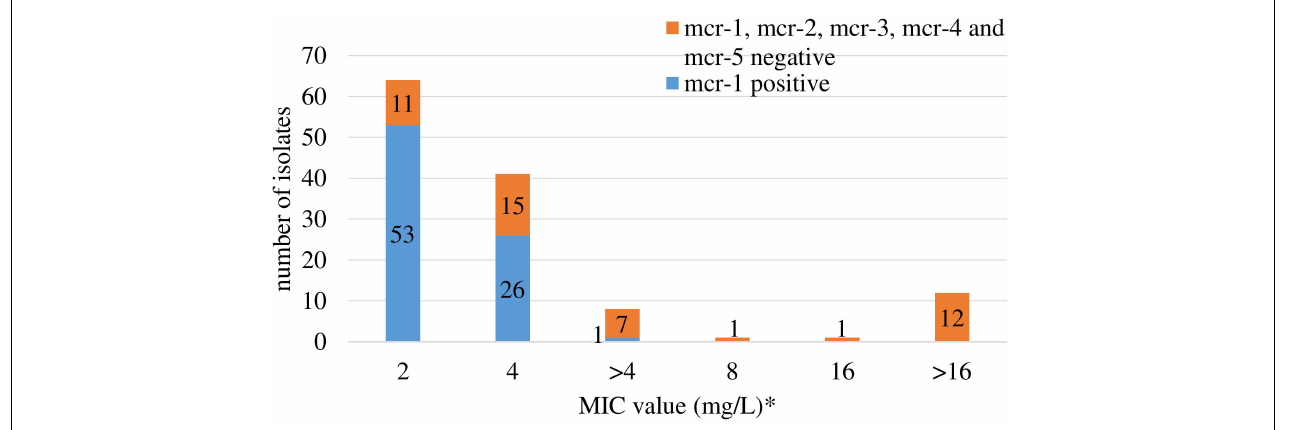
FIGURE 1 | Colistin MIC distribution and occurrence of the mcr-1 and mcr-2 gene among 128 Escherichia coli selected based on colistin MIC > 2 mg/L (2011–2013) and ≥ 2 mg/L (2014–2016). ∗ only isolates with MIC colistin ≥ 2 mg/L were tested for mcr-1 and mcr-2 genes. Different MIC values ( > 4 and 8, 16, and > 16) are result of changed MIC panel in plates. EUMVS2 plate (2–4 mg/L) was used in 2011–2013, EUVSEC plate (1–16 mg/L) in 2014–2016.